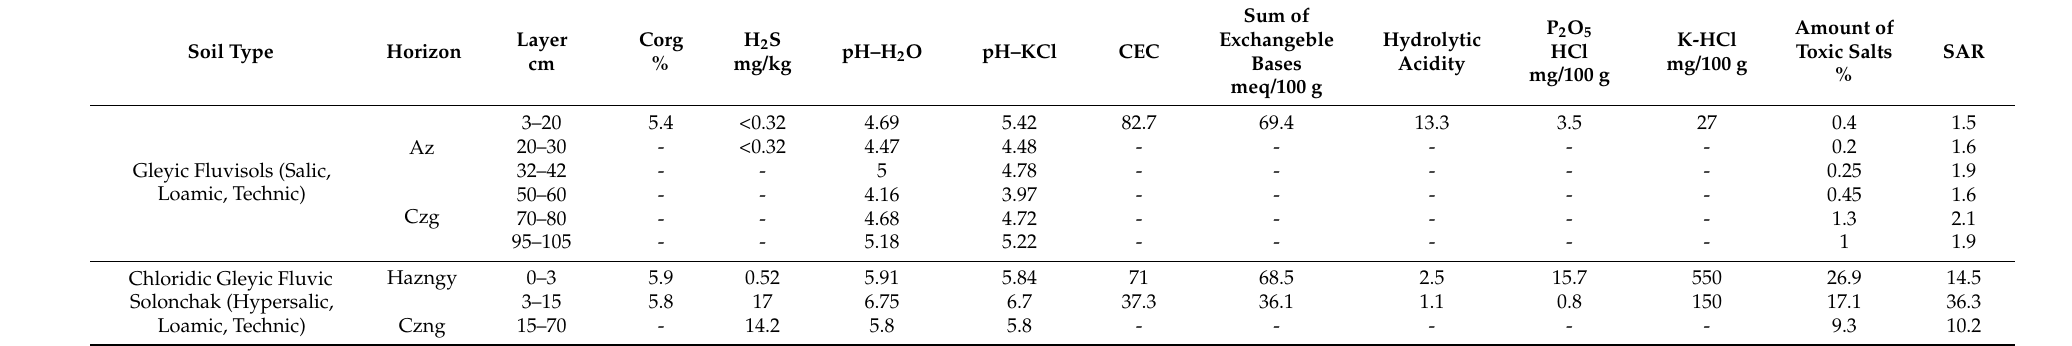
Table 2. Physicochemical properties of